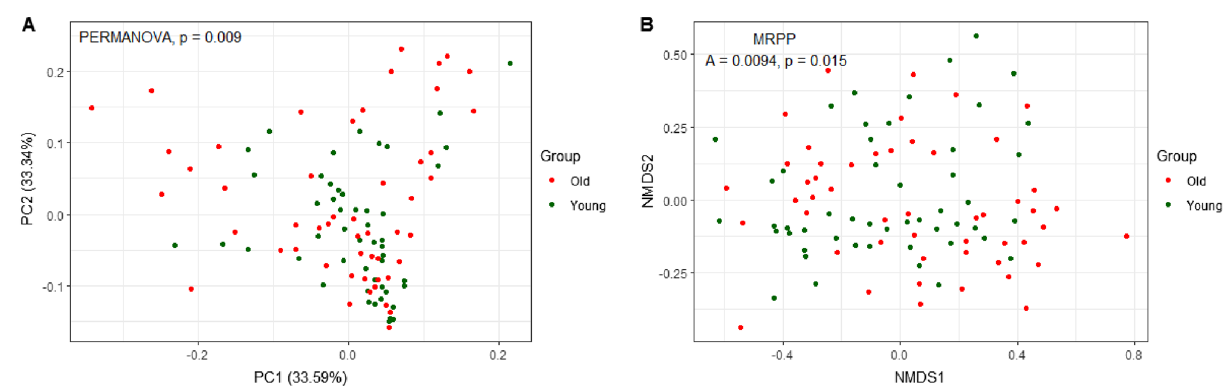
Figure 2. Beta diversity between the younger (young) and older (old) groups. ( A ) Principal coordinates analysis (PCoA) plot of UniFrac distances; ( B ) non-metric multidimensional scaling (NMDS) plot of generalized UniFrac distances. Red circles represent the older group, and green circles represent the younger group. P values are displayed in the